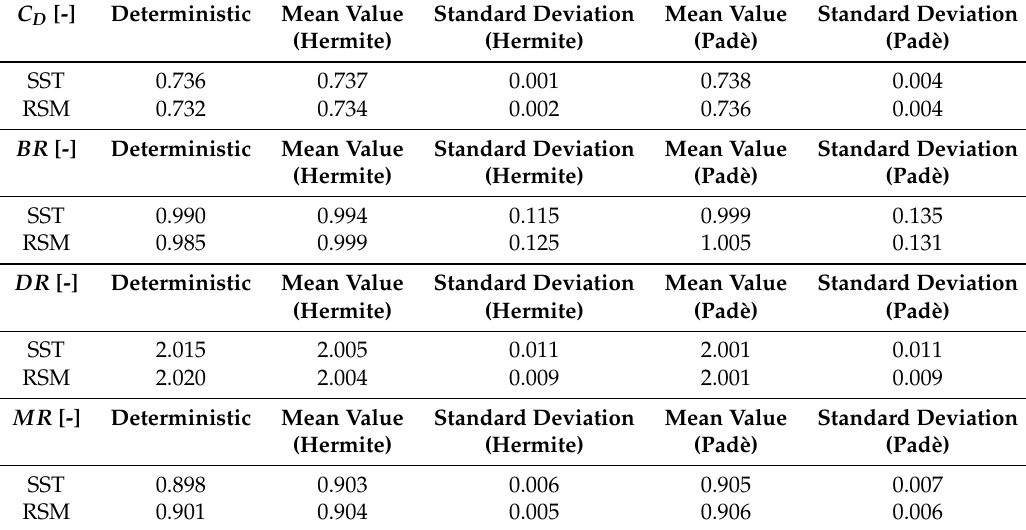
Figure 13. Blowing Ratio BR (Padè polynomials). Table 4. Mean value and standard deviation of BR, DR, MR e C D parameters and comparison with deterministic